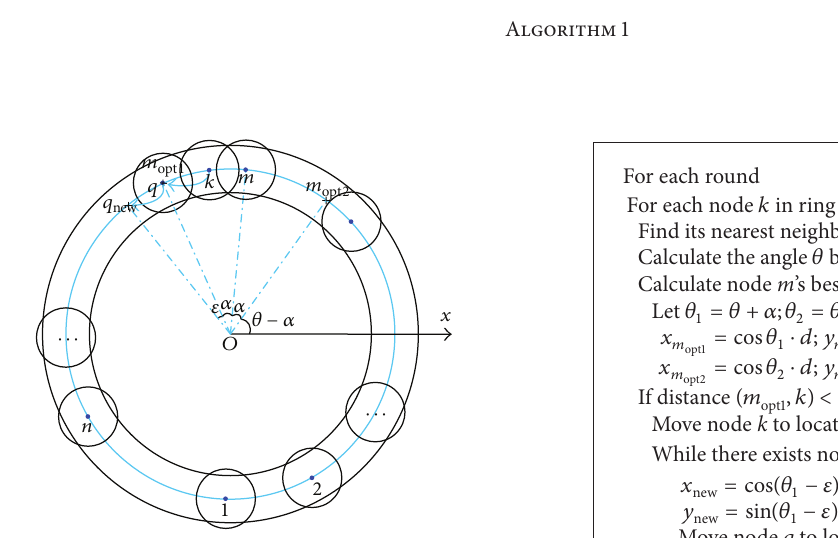
Figure 2: Sensor redeployment in the